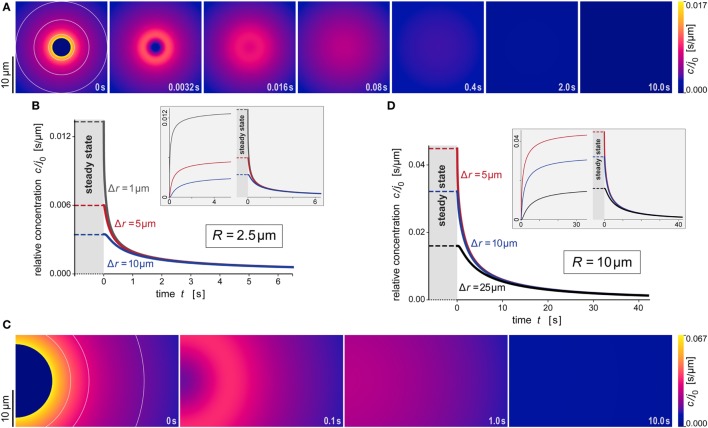
Predicted behavior of the dispersing anaphylatoxic cloud after removal of the source. (A–D) All panels are direct continuations of the respective panels of Figure 5, assuming that the source was suddenly removed at the newly reset time t = 0. The new initial profile was assumed to be given by Eq. 16, i.e., it was equal to the steady state for r ≥ R and zero for r < R. The insets in panels (B,D) include concentration curves of the earlier buildup of the anaphylatoxic cloud; these are the same as shown in Figures 5B,D. All concentrations were evaluated using the parameter values D = 130 μm2 s−1 and k = 1.1 × 10−2 s−1 typical for C5a.